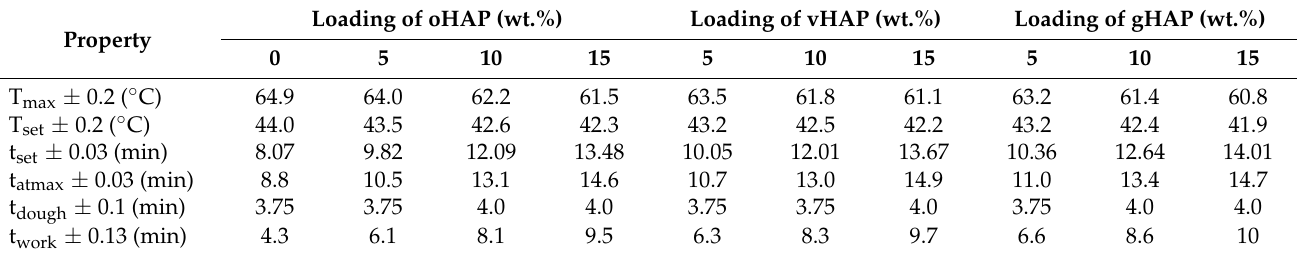
in dark grey areas without the white specks. The FEFEM images of the HAP-modified bone cements ( × 150) also show that the prepolymer bead sizes ranged from 30 to 110 µ